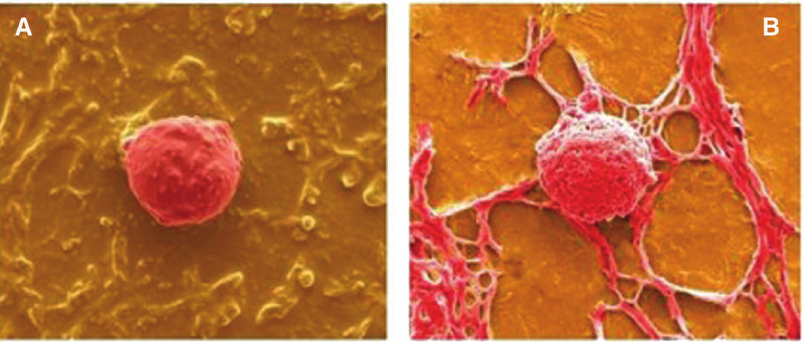
Figure 16: (A) PGS (B) PGS-Nanosilicate. Reprinted from Ref. [40], Copyright (2015), with permission from Elsevier.